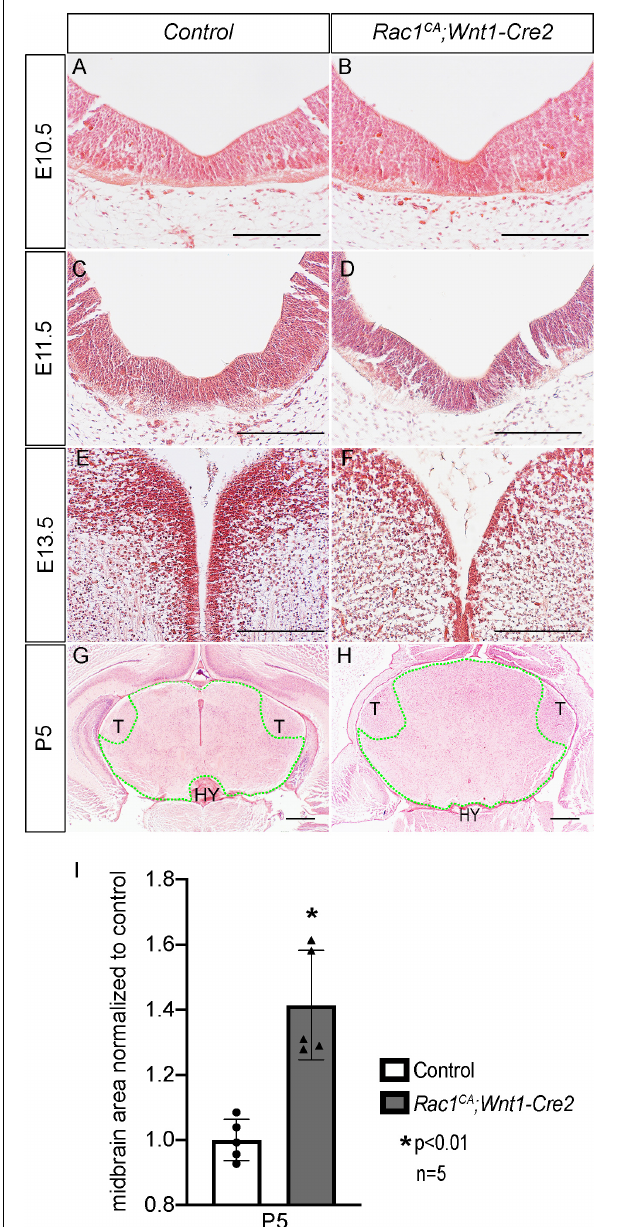
FIGURE 3 | Histological analysis of Rac1 CA ;Wnt1-Cre2 embryos. (A–H) H.E. staining on coronal sections of littermate control (A,C,E,G) and Rac1 CA ;Wnt1-Cre2 (B,D,F,H) at E10.5 (A,B) , E11.5 (C,D) , E13.5 (E,F) , and P5 (G,H) at midbrain level. (I) Scatter plot of statistical analysis of midbrain area (outlined by green dots) quantified in (G,H) . Scale bar in A–H , 200 µ m. HY, hypothalamus; T, thalamus.